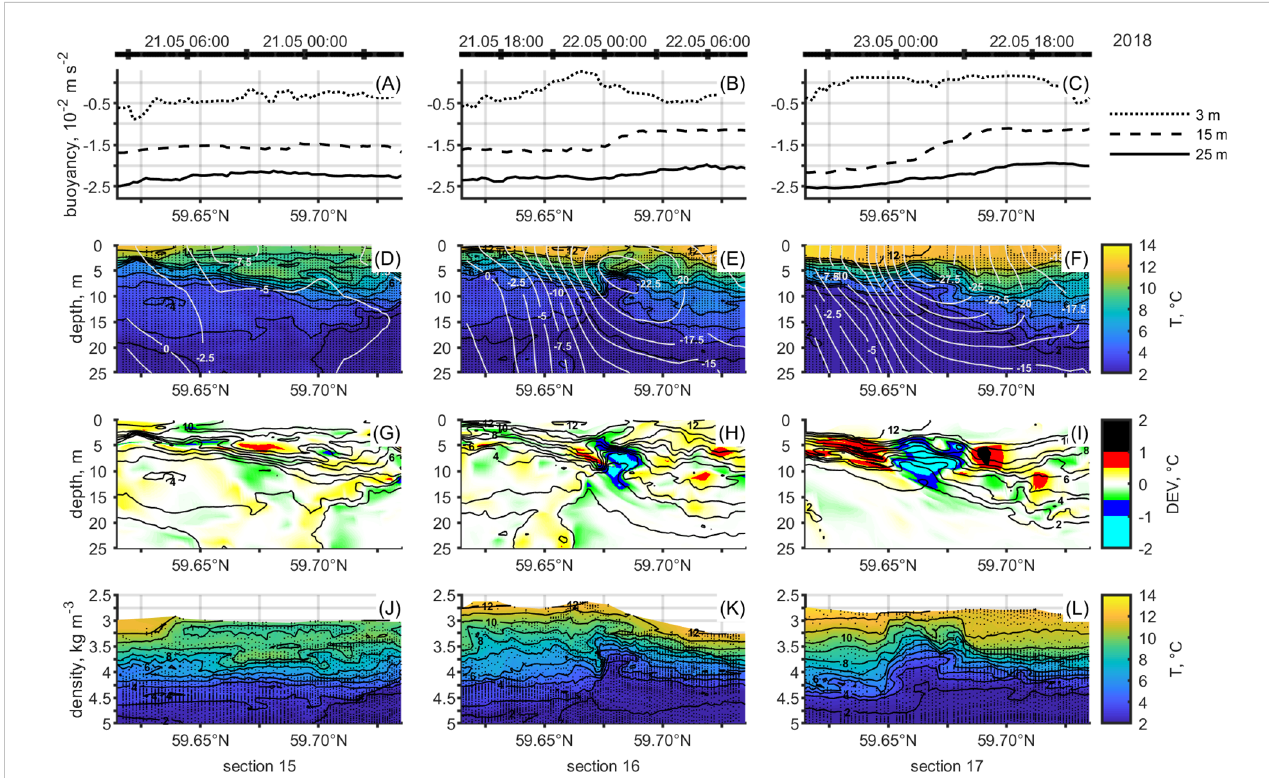
FIGURE 4 (A – C) Buoyancy along the glider transect at 3, 15, and 25 m depth on 20 – 23 May 2018. (D – F) Temperature distributions (black contours with a step of 1° C) as a function of depth (0 – 25 m) overlaid with white contours marking the relative geostrophic velocity (positive values show eastward movement) with a step of 2.5 cm s -1 on 20 – 23 May 2018. The sampling timeline is at the top of the columns. The left side of a subplot is located closer to the coast and presents the southern part of the section. The area between ticks presenting latitude is about 2.7 km. (G – I) Temperature deviations as a function of pressure along the glider section on 20 – 23 May 2018. Black contours mark potential density anomaly with a step 0.1 kg m -3 . (J – L) Isopycnal temperature distributions (black contours with a step of 1°C) along the glider section on 20 – 23 May 2018.